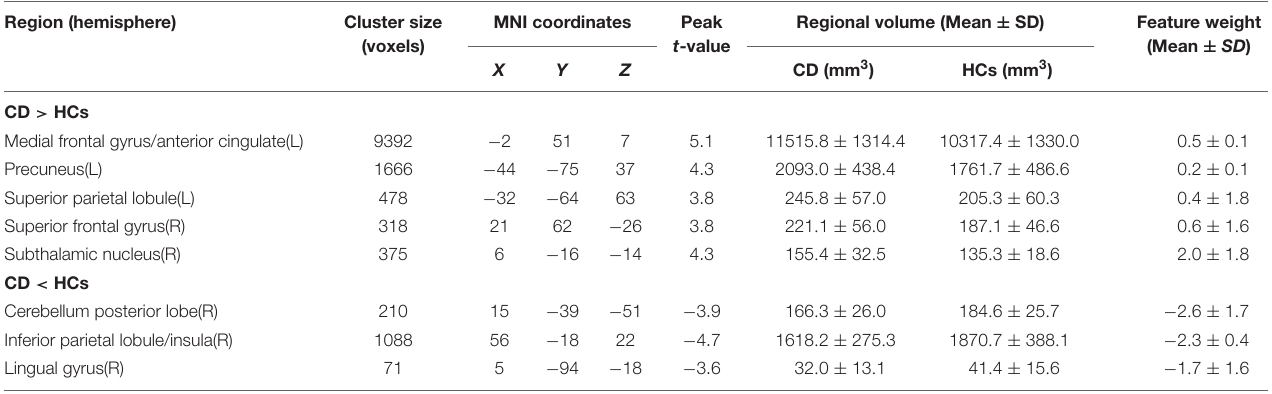
TABLE 2 | Gray matter differences between CD group and HC group by VBM analysis. Region (hemisphere)